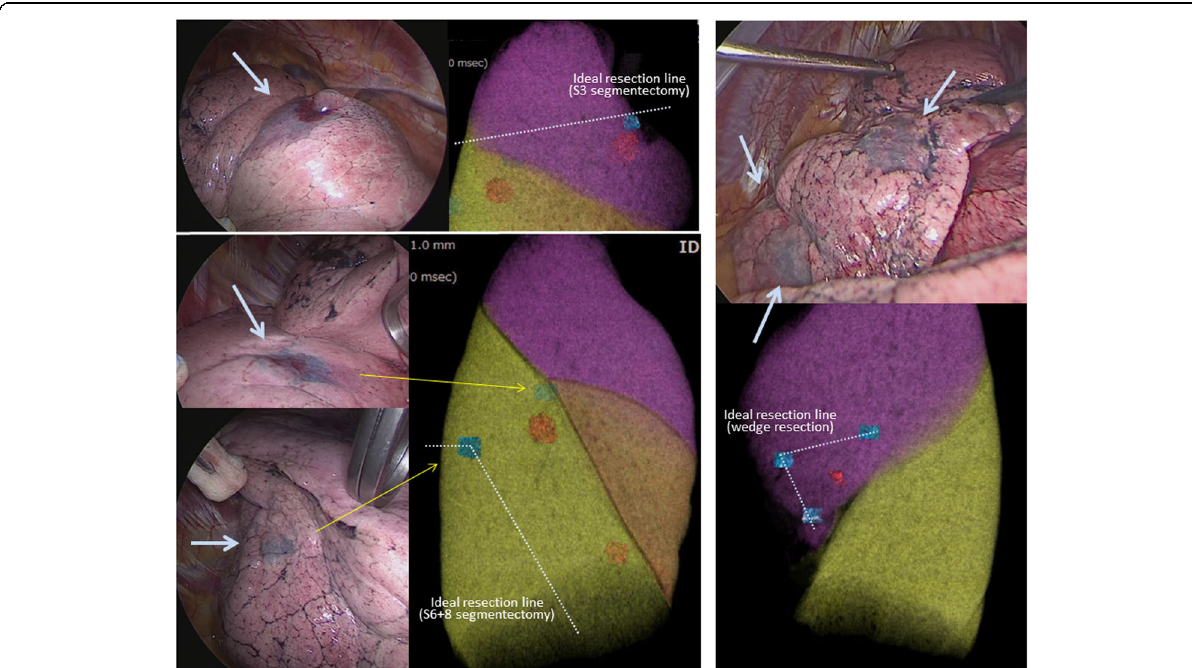
Fig. 2 Three-dimensional images for planning of “ virtual-assisted lung mapping (VAL-MAP) ” indicating target nodules (red) and planned markings (blue) and thoracoscopic view of actual markings (blue) on the lung surface. (Left upper) A marking spot was designed to indicate an ideal resection line in S3 segmentectomy. (Left lower) A marking spot was designed to indicate an ideal resection line in complex segmentectomy of S6 plus S8, and another spot was designed to identify the target lesion (pure GGN) in S6. (Right) Three markings were designed to indicate an ideal resection line in wedge resection for the small pure GGN (8 mm) in the lingular